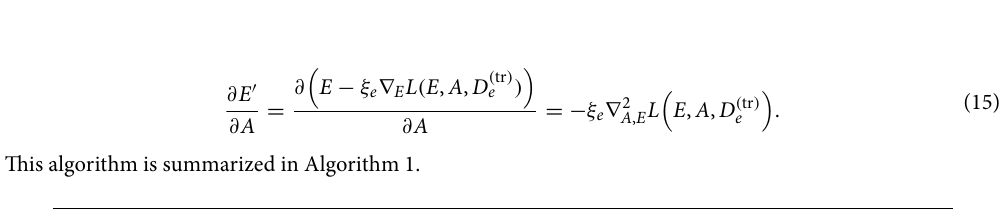
Table 2. The number of training and test examples for each brain tumor